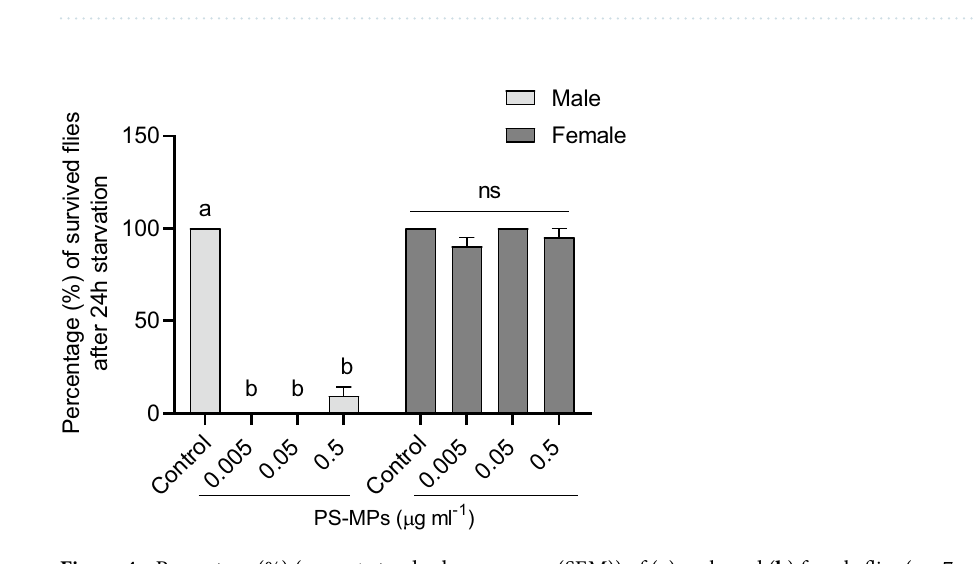
Figure 4. Percentage (%) (mean ± standard error mean (SEM)) of ( a ) male and ( b ) female flies (n = 7 pairs) survived after 24 h of starvation. Newly emerged flies (male and females) were exposed to different concentrations of polystyrene microplastics (PS-MPs) before being starved for 24 h. All female flies survived while almost all male flies died regardless of the concentration of PS-MPs. Different lowercase letters indicate statistical differences between treatments (One way ANOVA, p < 0.05). ns, indicate no significant